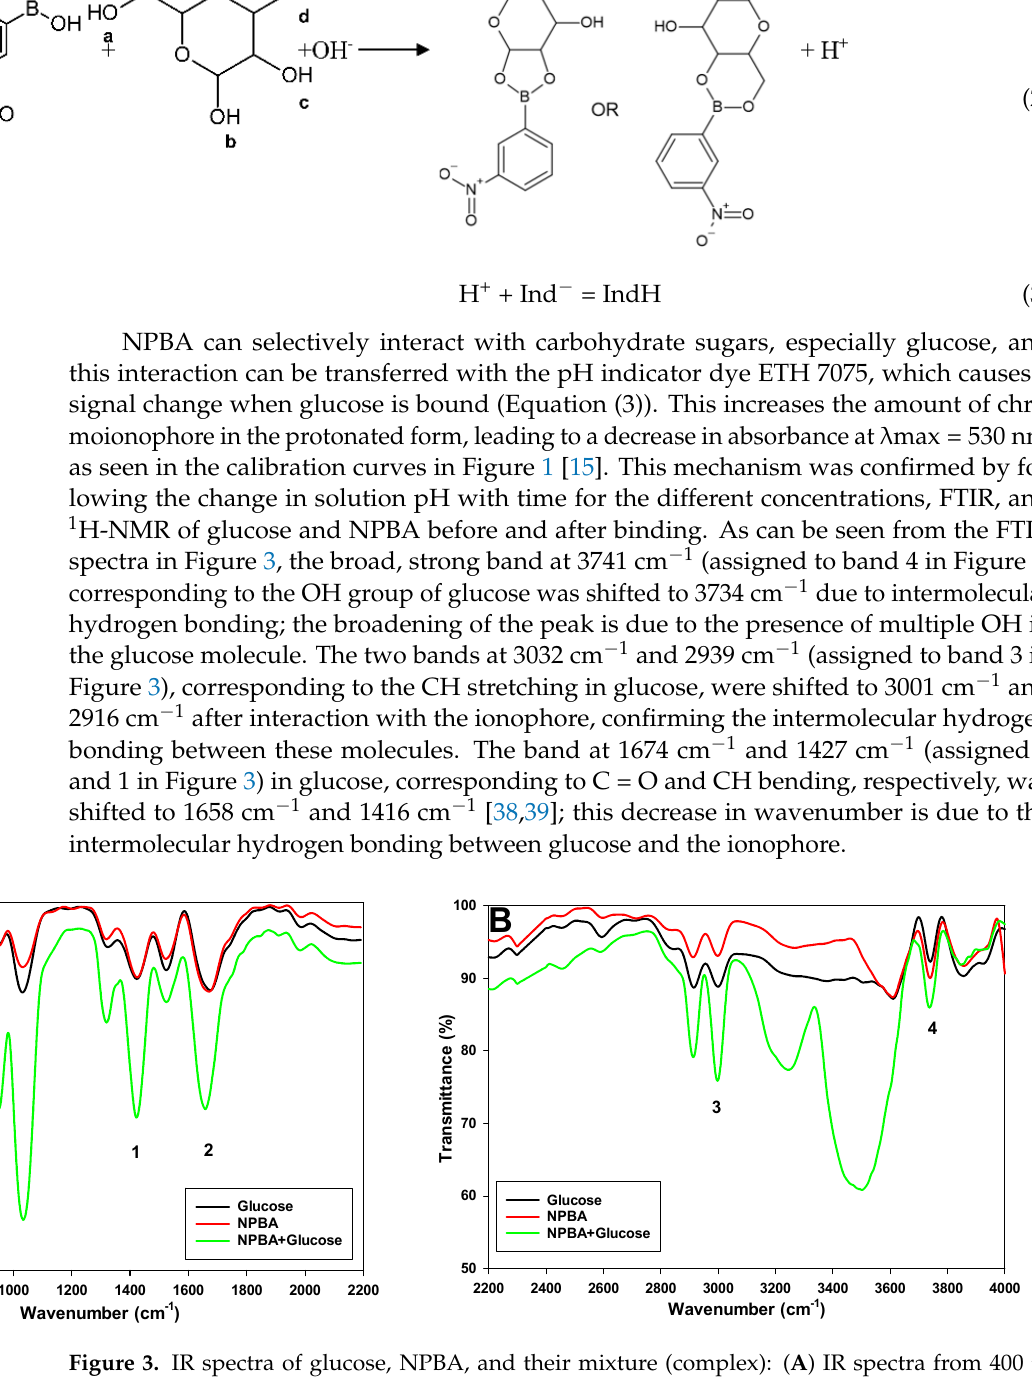
Table 2. 1 H-NMR chemical shift of glucose, the ionophore NPBA, and their mixture in deuterated DMSO [39,40].